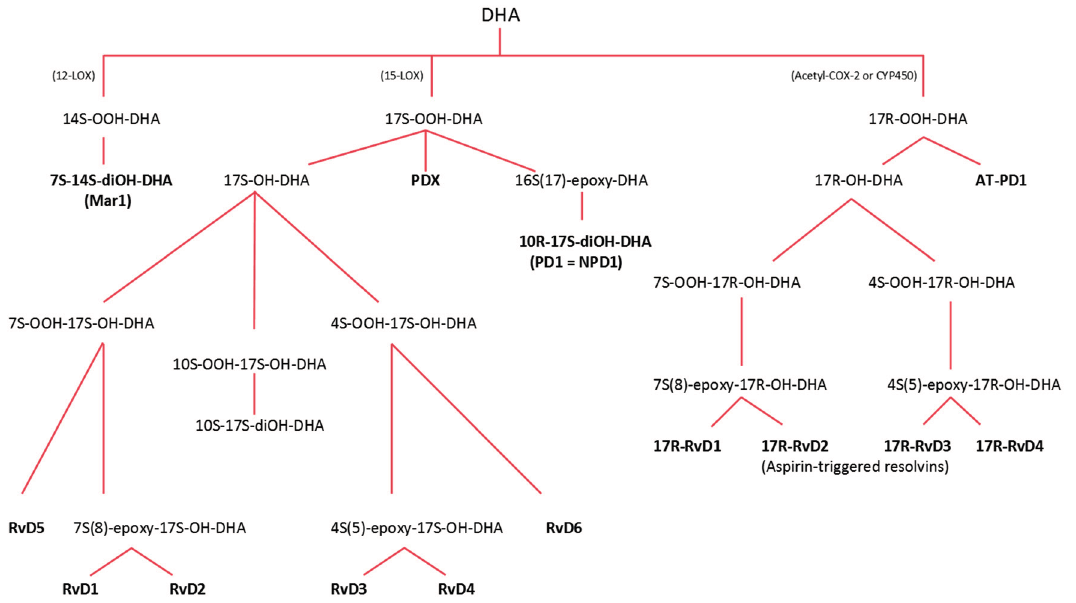
Figure 2. Overview of the pathways involved in the production of specialized pro-resolving mediators from docosahexaenoic acid (DHA). The figure is adapted from [17]. Through the lipoxygenase (LOX) pathway, LOX-12 catalyzes the production of maresin-1 (Mar-1), while 15-LOX catalyzes the formation of neuroprotectin D1 (NPD1), protectin DX (PDX) and resolvins D1 (17 S -RvD1) to D6 (17 S -RvD6). Aspirin-acetylated cyclooxygenase-2 (COX-2) and/or cytochrome P-450 (CYP-450) catalyzes the formation of aspirin-triggered resolvins D1 (17 R -RvD1) to D4 (17 R -RvD4), along with aspirin-triggered protectin D1